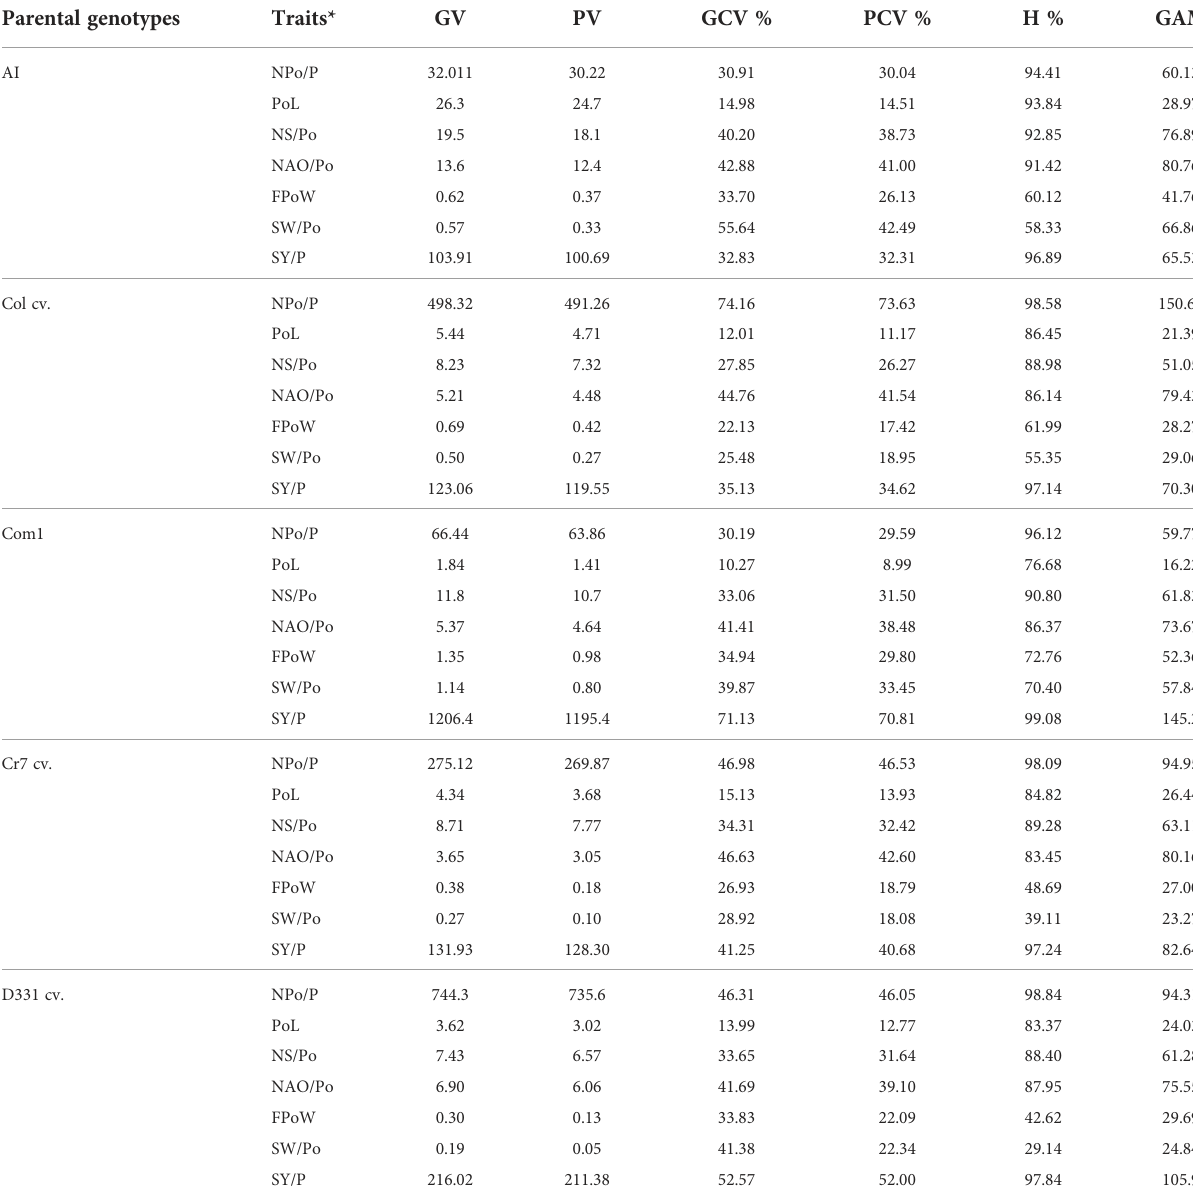
TABLE 5 Genotypic variance (GV), phenotypic variance (PV), genotypic coef fi cient of variance (GCV %), phenotypic coef fi cient of variance (PCV %), heritability (H%), and genetic advance mean (GAM) of pods, seeds traits and yield of the fi ve parental genotypes; local commercial cultivars, i.e., Cream 7 ‘ Cr7 ’ , Dokki 331 ‘ D331 ’ , and introduced cultivars, i.e., Colossus ‘ Col ’ and Asian Introduction ‘ AI ’ . Another cultivar, Commercial 1 ‘ Com1 ’ , was collected from the local market in El-Minia governorate for its seed ’ s quality